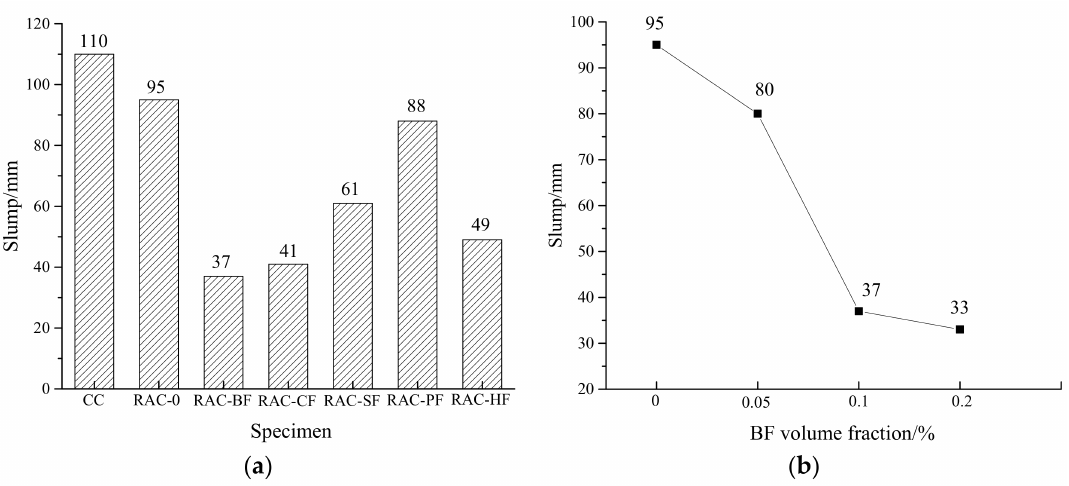
Figure 2. Changes in RAC slumps. ( a ) Different fiber-reinforced RAC; ( b ) Different BF-reinforced